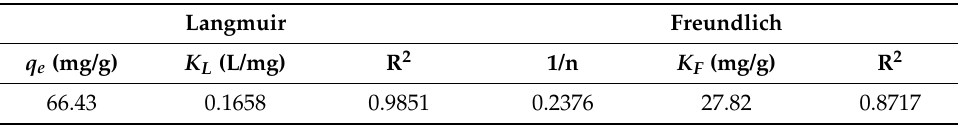
Table 2. Adsorption isotherm parameters of AC on N-SC/ β -CD-MOFs. Langmuir